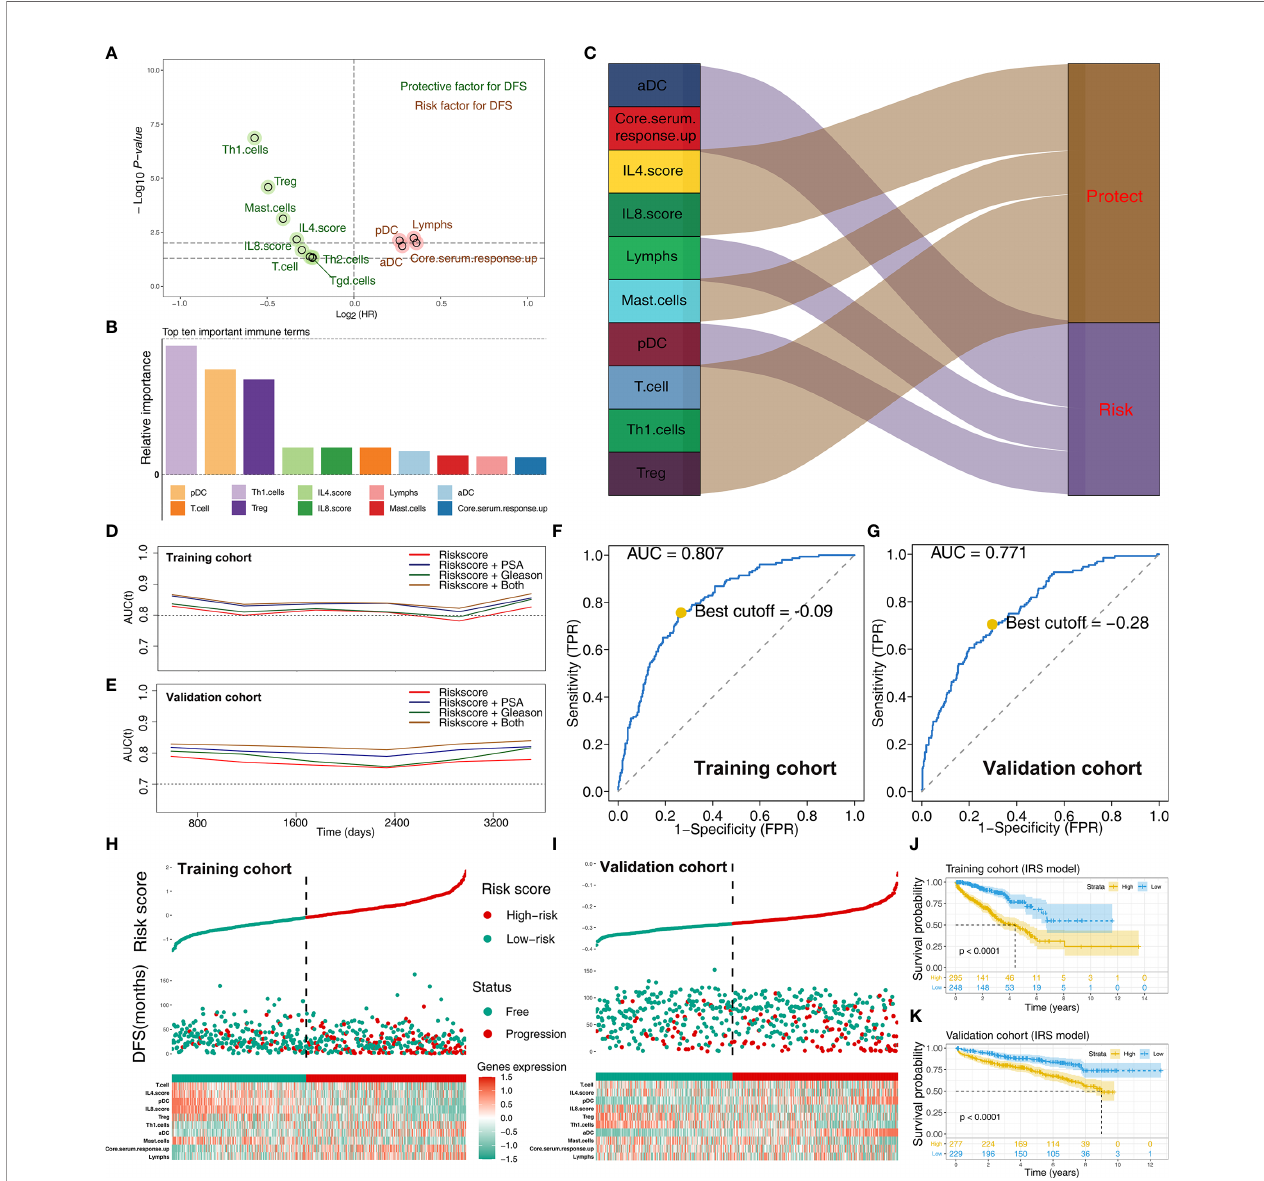
FIGURE 3 | Screening of important immune terms and IRS calculation. (A) Volcano plot of 12 prognosis-related immune terms preliminarily identi fi ed by univariate Cox analysis with the screening criteria p -value <0.05 in training cohort. The red circles represent HR >1 (risk factors), and green circles represent HR <1 (protective factors). (B) The top 10 important immune terms based on the relative importance calculated by random forest algorithm and selected for IRS calculation. (C) The integrated Sankey diagram illustrated the prognosis effect of these 10 immune terms. (D, E) The timeROC plot showed that IRS signature has stable predictive ability of DFS in a different time (training cohort and validation cohort). (F, G) The optimum cutoff points for the IRS was established using the ROC analysis (training cohort and validation cohort). (H, I) The risk plot showed a higher percentage of progressed patients in the high IRS group (training cohort and validation cohort). (J, K) Kaplan-Meier curve of the DFS prognosis in high and low IRS